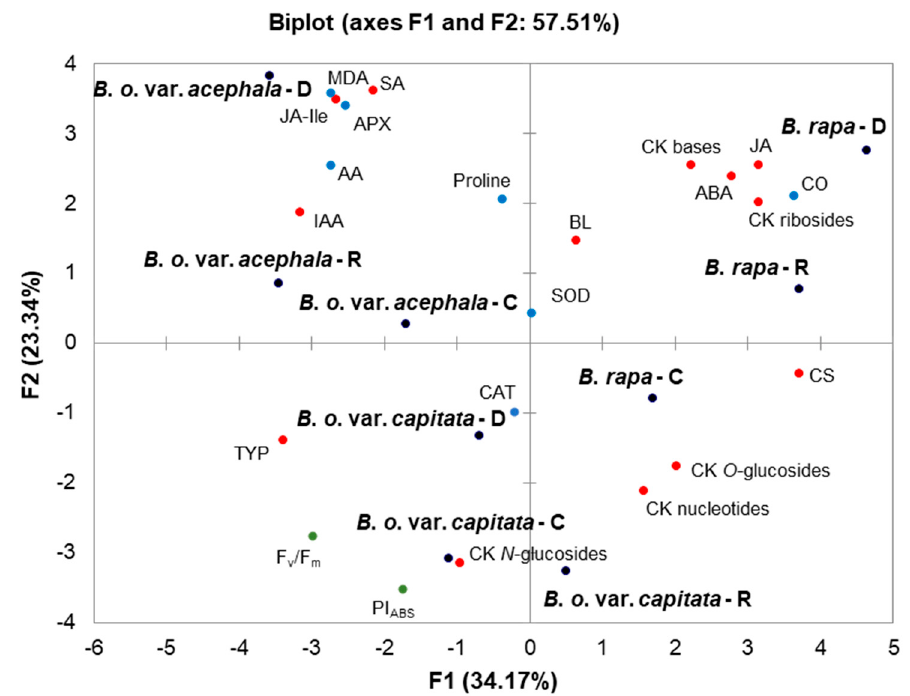
Figure 9. The two-dimensional principal component analysis (2D-PCA) of drought and recovery of B. rapa , B. oleracea var. capitata , and B. oleracea var. acephala , and resulting biochemical and hormonal responses. PCA was performed on the correlation matrix of standardized average values of biochemical parameters (Table 1, Figures 3 and 4), and phytohormone profiles (Figures 5–8). Cytokinins are presented as total CK groups. Green, blue and red dots present photosynthetic parameters, biochemical markers, and phytohormones, respectively. Treatments: drought ( D ), recovery ( R ) and the control ( C ). Correlation matrix data, eigenvalues, factor loadings and factor scores are given in Supplementary Tables S10–S14.